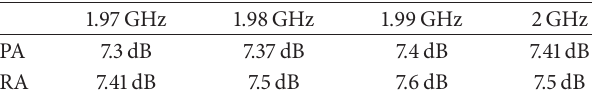
Table 2: LHCP gains of PA and